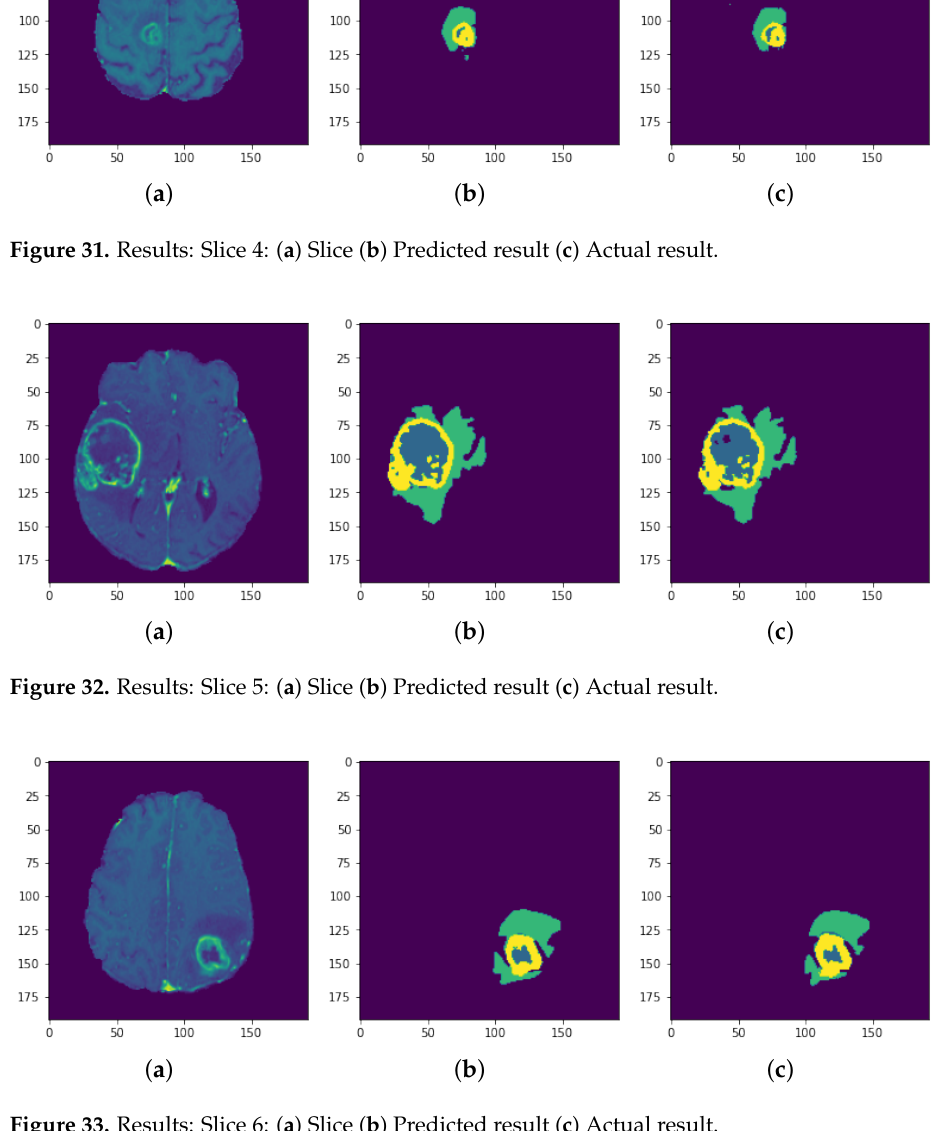
Figure 33. Results: Slice 6: ( a ) Slice ( b ) Predicted result ( c ) Actual